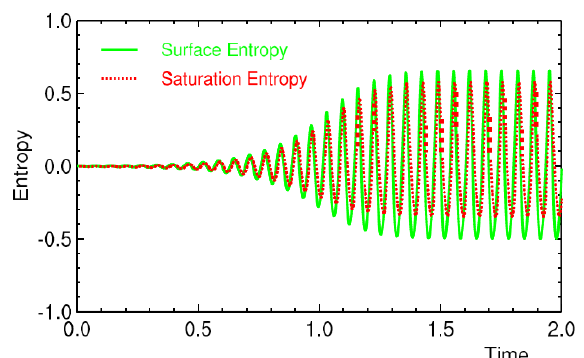
Figure 15. Time series of (green) X 2 the dimensionless surface entropy in the test column and (red) Y 2 the saturation moist entropy at z = 2 km in the reference column in the system of Equation (22) and Equation (24) (see Appendix C for the definitions and parameters used). The horizontal axis of time is scaled with 2𝜏 𝑡 = 28 days as the unit.